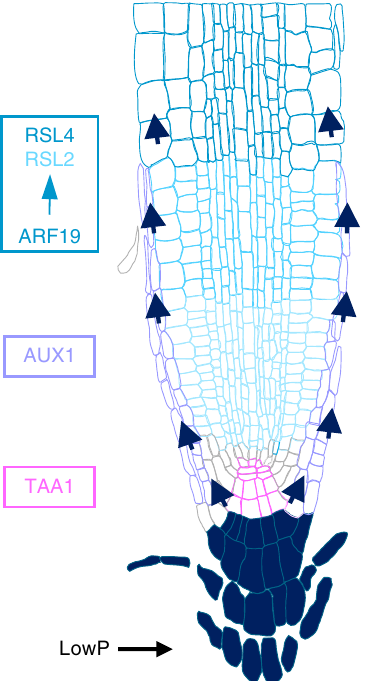
Fig. 6 Model for root hair elongation under low P. Low P elevates IAA levels in the root apex facilitated by TAA1 mediated auxin synthesis and AUX1 dependent auxin transport. The resulting increase in IAA levels leads to the induction of ARF19 in the root apex resulting in RSL2 and RSL4 induction in the elongation and differentiation zones, respectively, promoting root